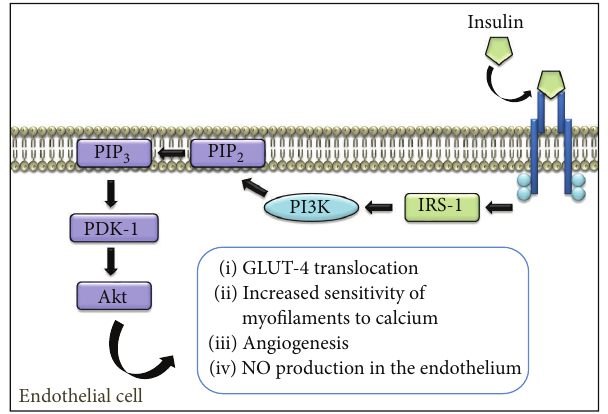
Figure 2: Mechanism of action of insulin in the endothelial cell. The interaction of insulin with its receptor results in autophospho- rylation of tyrosine residues and heterophosphorylation of second messengers such as IRS-1, which phosphorylates PI3K, leading to the activation of a cascade of phosphorylation ending with expression of various physiological effects, like the production of endothelial NO. IRS-1: insulin receptor substrate 1, PI3K: phos- phatidylinositol 3-kinase, PIP 2 : phosphatidylinositol diphosphate, PIP 3 : phosphatidylinositol triphosphate, PDK-1: dependent kinase PI3K,Akt:proteinkinaseB,GLUT-4:glucosetransporter4,andNO: nitric